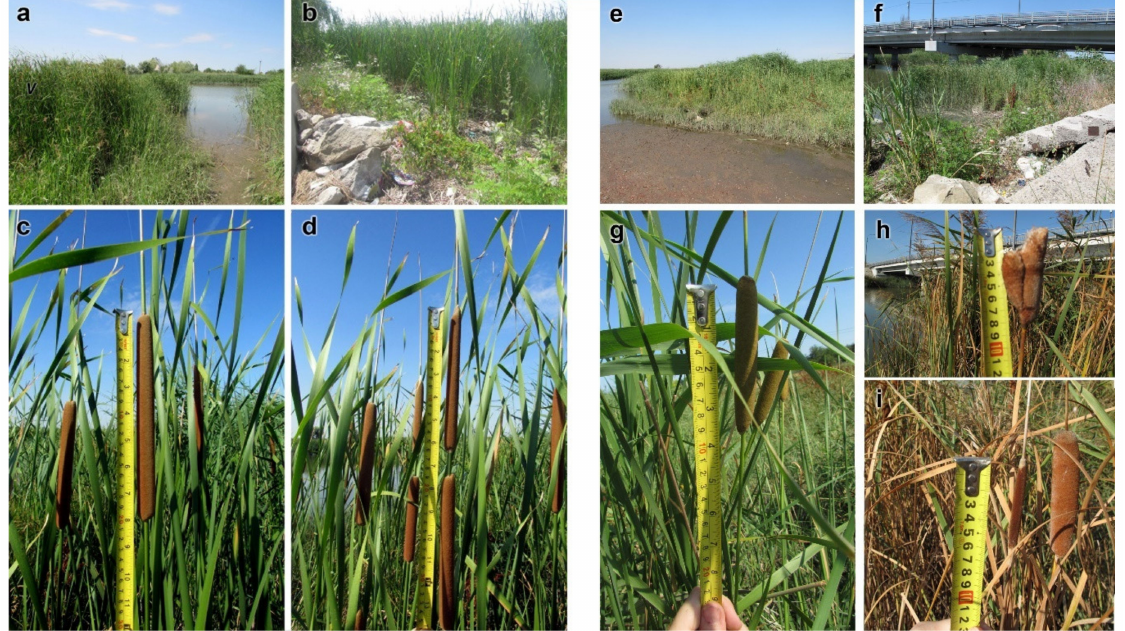
Figure 2. The general view of the monitoring plots and plants features; T. australis: ( a ) background plot (5K), ( b ) polluted plot (8K), ( c ) normal plant (plot 5K) and ( d ) plant with anomalies (plot 8K); T. laxmannii : ( e ) background plot (T1), ( f ) polluted plot (T4), ( g ) normal pistillate (plot T1); ( h , i ) deformed pistil spike (plot